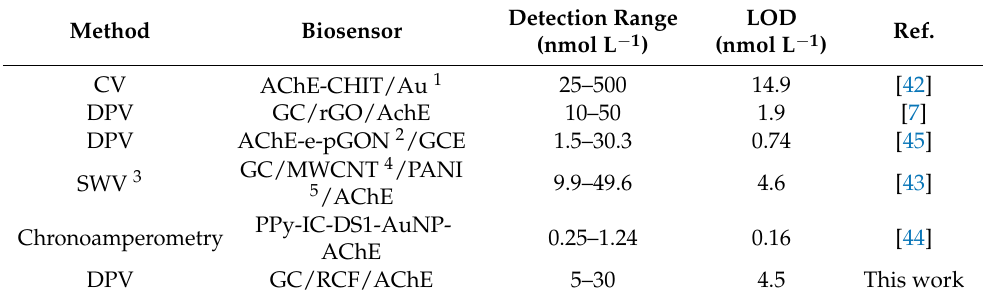
Table 1. Comparison of analytical characteristics with other biosensors reported for carbaryl detection.